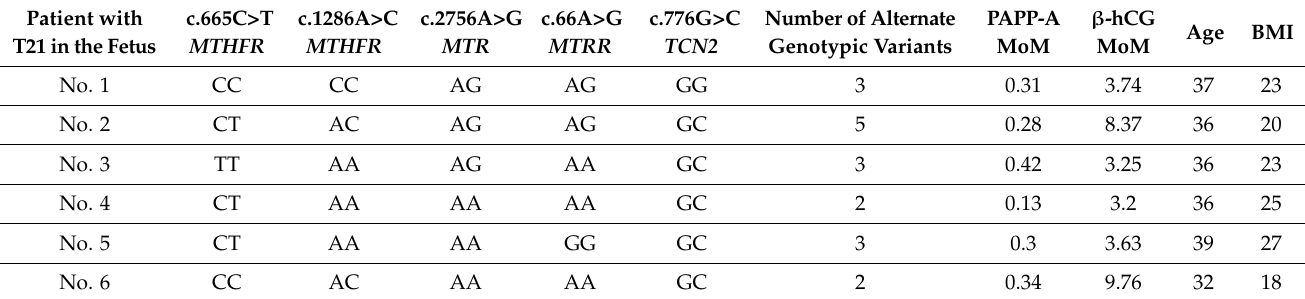
Table 6. Distribution of individual gene variants of the folate pathway in patients with abnormal PAPP-A MoM results and trisomy 21 in the